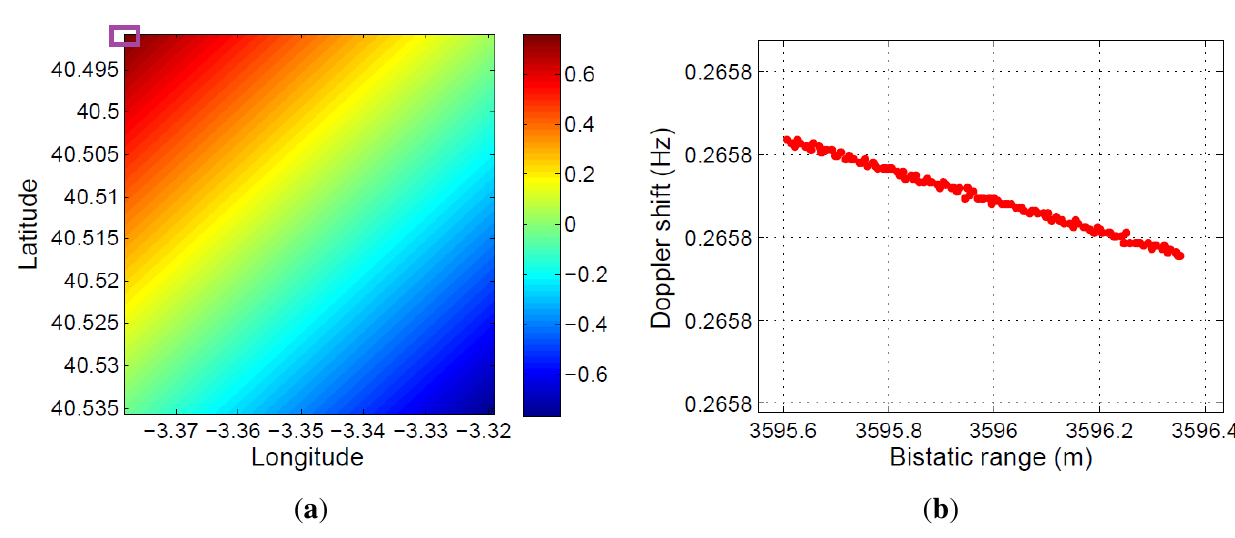
Figure 25. System geometry analysis for Navstart 59 (USA 192), on 25 May 2015, at 12:20:00: ( a ) total variation of the bistatic range during the acquisition time; ( b ) virtual displacement associated with the satellite